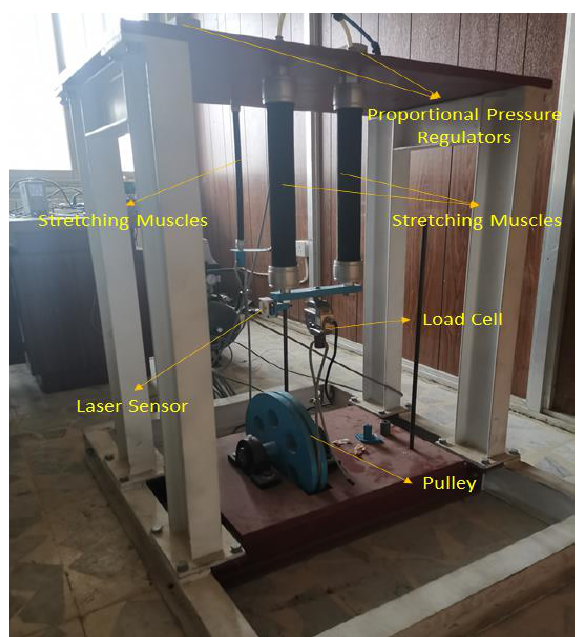
Figure 2. Antagonistic experimental